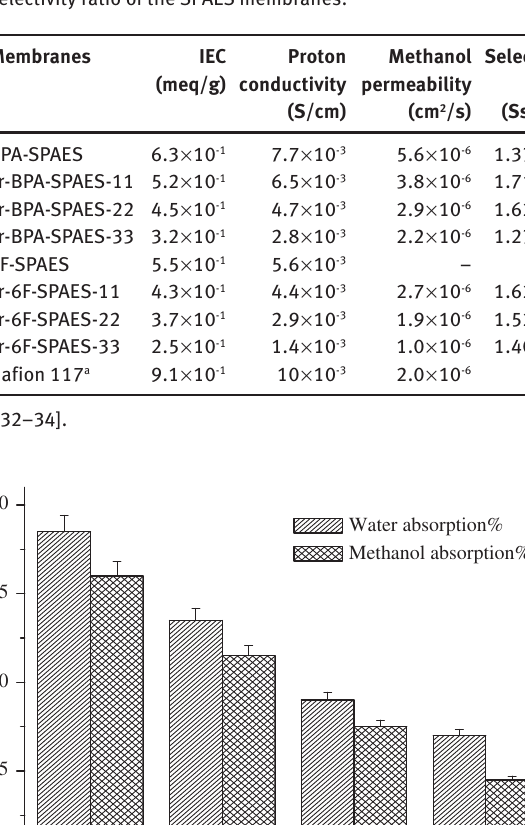
Table 1: IEC, proton conductivity, methanol permeability and selectivity ratio of the SPAES membranes.